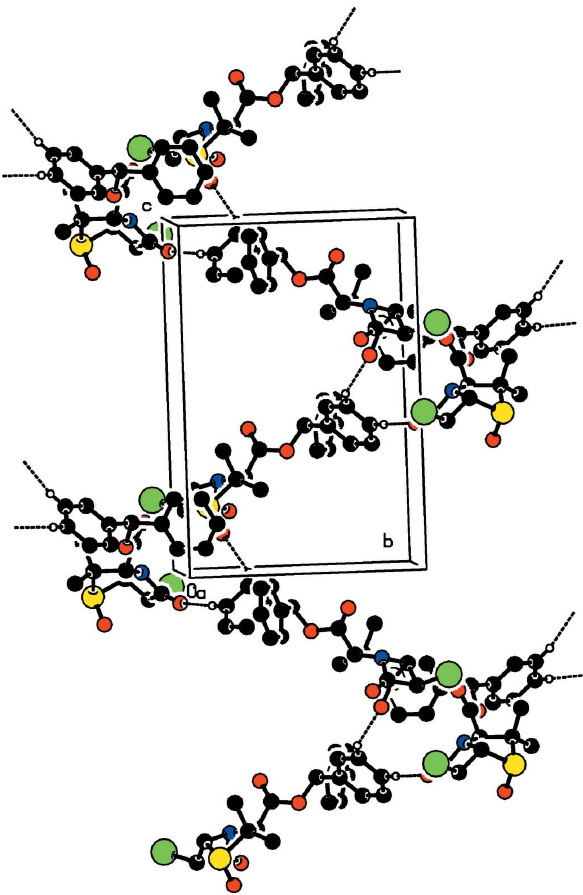
Figure 2 A partial packing diagram for the title compound. Dashed lines indicate the C—H (cid:2)(cid:2)(cid:2) O hydrogen